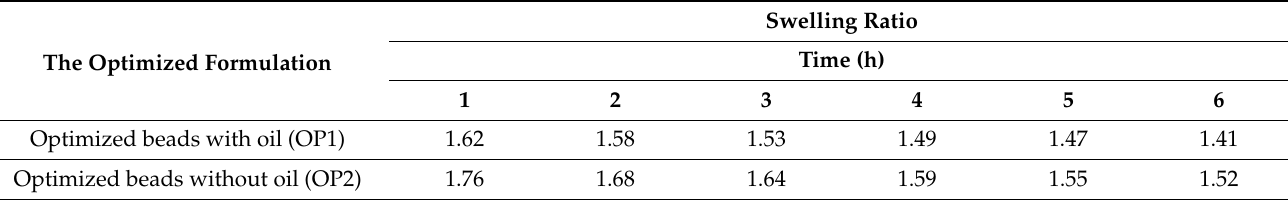
Table 8. Swelling ratio of optimized formulation (OP1 and